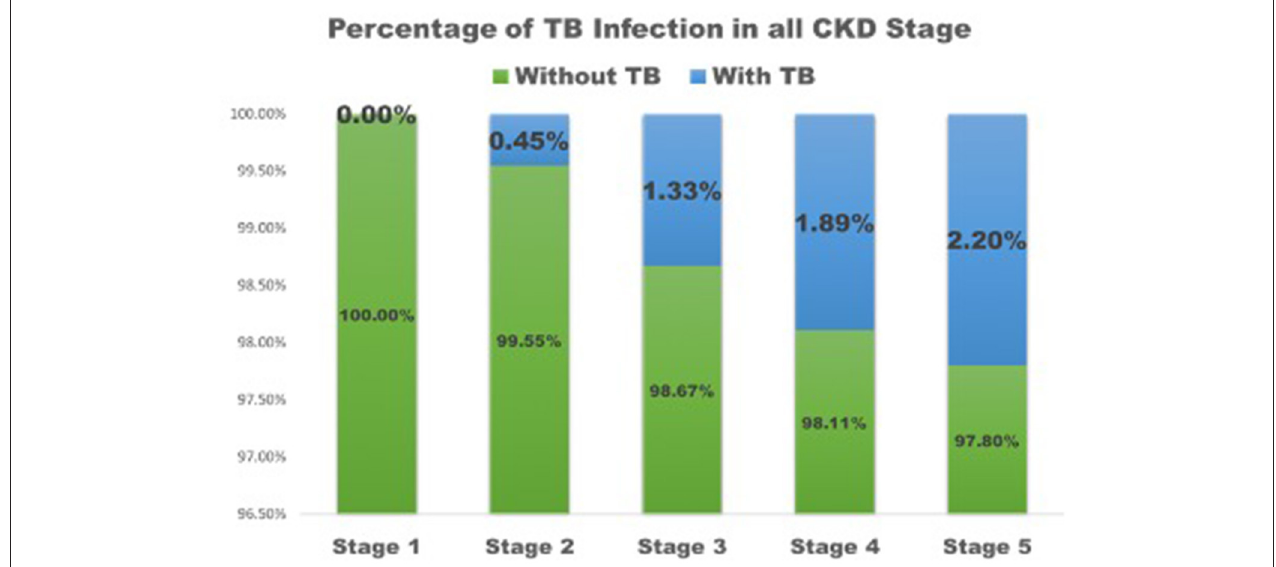
FIGURE 1 | The percentage of TB infection in all CKD stage. TB, tuberculosis; CKD, Chronic kidney disease.